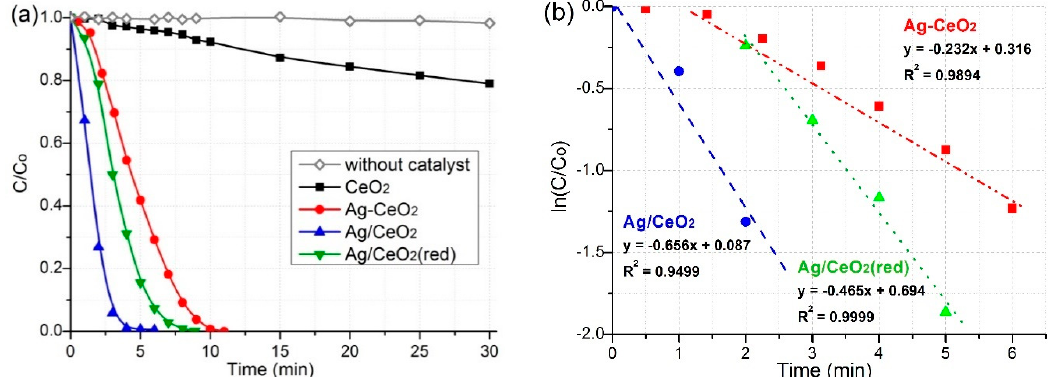
Figure 6. The dependences of p-nitrophenol concentration on time for different catalysts ( a ) and corresponding linearization of kinetic data in pseudo-first order coordinates ( b ).